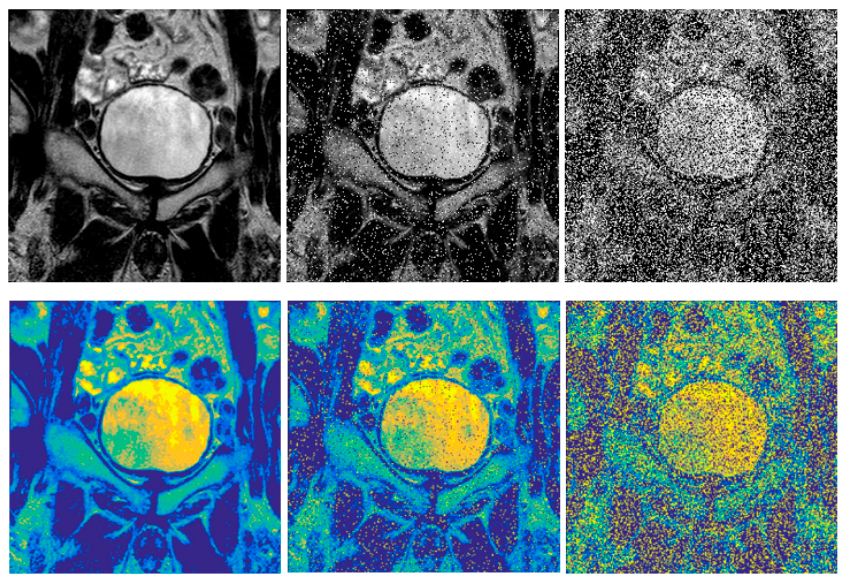
Figure 8. Extract of MR images: native MR image ( up left ), Salt and Pepper: d = 0.1 ( up middle ), and d = 0.5 ( up right ). Regional segmentation based on Fuzzy thresholding with 8 classes: segmentation of native image ( down left ), Salt and Pepper: d = 0.1 ( down middle ), and d = 0.5 ( down right ).